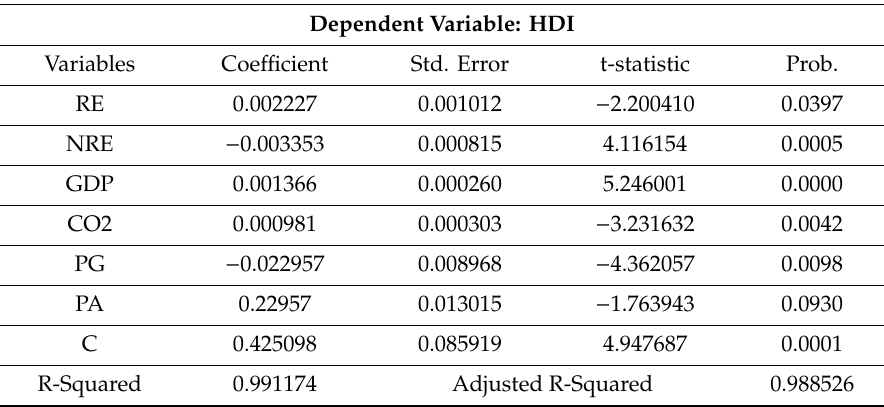
Table 4. Fully modified least squares